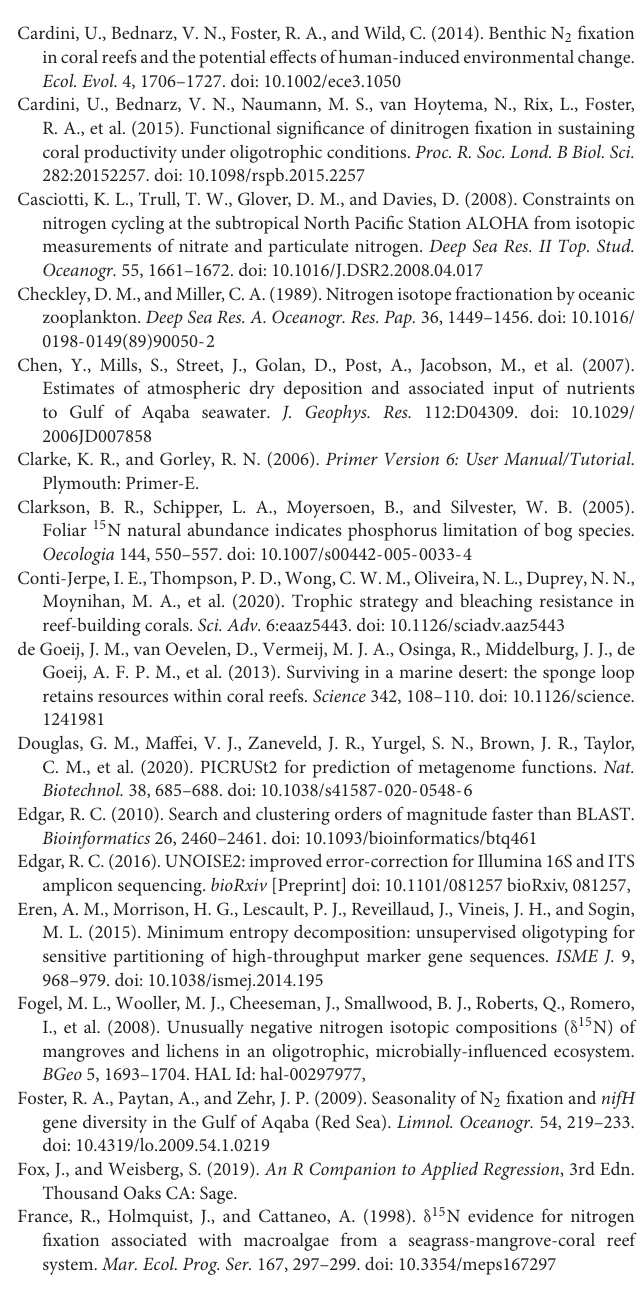
Supplementary Figure 1 | Overview of the composition of the overall bacterial community associated with Stylophora pistillata corals collected along a depth gradient (5, 25, and 50 m) in summer and winter in the Gulf of Aqaba. The relative abundance of each taxon within the community is indicated in percentages (%). Supplementary Figure 2 | Phylogeny of the nifH operational protein units (OPU) recovered from Stylophora pistillata corals collected along a depth gradient (5, 25, and 50 m) in summer and winter in the Gulf of Aqaba. Reconstruction of the maximum-likelihood phylogenetic tree was based on the nifH sequences using the Whelan and Goldman (WAG) model. The 34 newly identified nifH OPUs from S. pistillata are denoted as “MED” and their closest relative sequence match (accession number; taxon; match, and e -value) is listed. Boot strap support > 60% is indicated on applicable